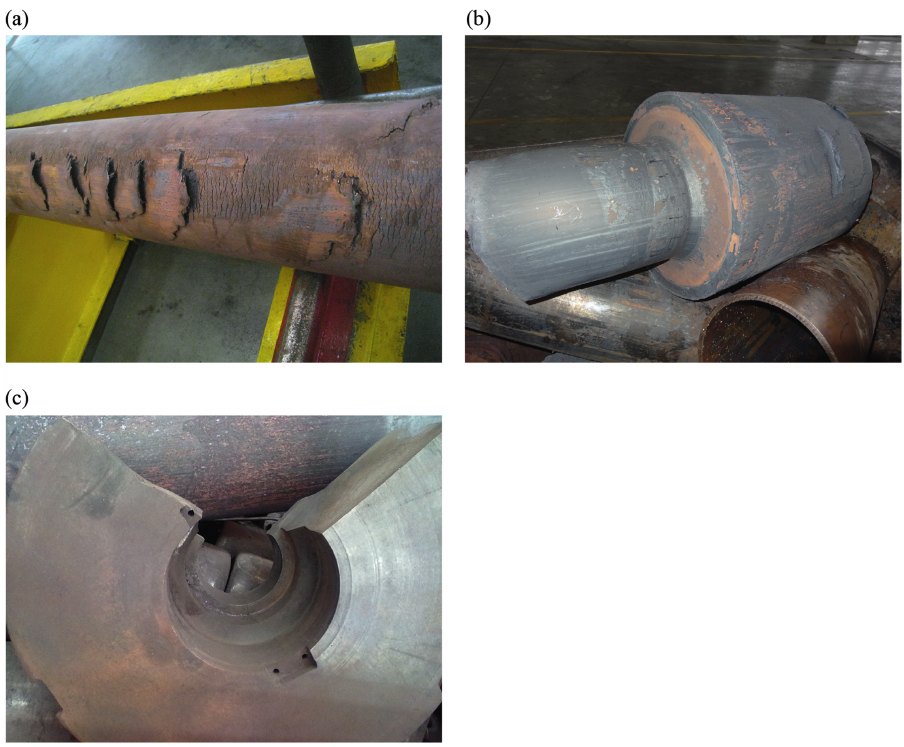
Figure 1: Defect of BFe10-1-2 alloy pipes during hot extrusion (a) surface crack; (b) overload; (c) die fracture.